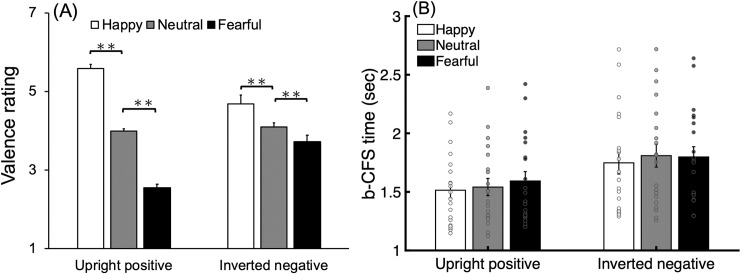
Results in Experiment 1.(A) Valence rating in the explicit emotion judgment task. Scale 1 referred to negative valence and scale 7 referred to positive valence. (B) Mean b-CFS time for detecting upright-positive and inverted-negative faces with happy, neutral, and fearful facial expression. Error bars represent one standard error from the mean and the scatter plot represents the individual data. * p < .05; **p < .01.